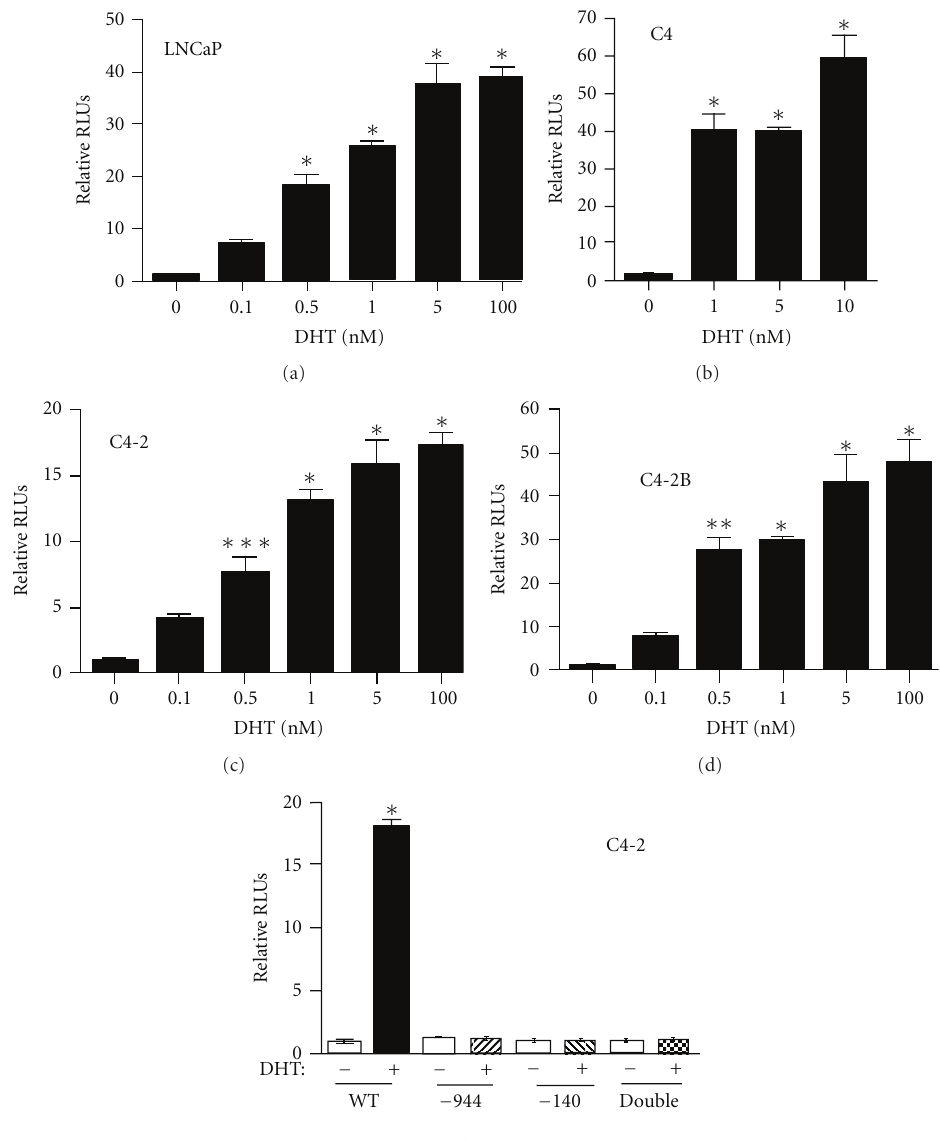
Figure 6: DHT induces the tcf8 promoter plasmid in a dose-dependent manner in LNCaP cell line derivatives . The LNCaP (a), C4 (b), C4-2 (c), and C4-2B (d) cell lines were transfected with the pBlueZEB974 promoter plasmid and then cultured with increasing DHT as indicated. The cells were harvested after 24 hrs and the β -galactosidase activity in the lysates was determined. (e) C4-2 cells were transfected with the wild type pBlueZEB974 plasmid or with the plasmids containing one or both AREs mutated. Data are plotted relative to the average with no DHT. ∗ P < 0 . 0001, ∗∗ P < 0 . 01, ∗∗∗ P < 0 . 05. line established from a lymph node metastasis [42]. The LNCaP C4-2 and C4-2B lines are two derivatives that have metastatic potential. They are androgen independent (Figure 6(c)), or C4-2B (Figure 6(d)) cell lines with in- for growth in castrated hosts but still have androgen- creasing amounts of DHT. In all cases, expression of the responsive AR. We hypothesized that ZEB1 expression tcf8 promoter was strongly induced by DHT in a dose- increases independently of androgen in these metastatic lines dependent manner, and the level of expression did not and contributes to androgen-independent PCa cell prolifer- correlate with metastatic potential. However, in contrast to ation, comparable to what occurs with ZEB1 expression in what was observed with the PC-3/AR cells (Figure 1), high advanced ovarian and endometrial cancers [40]. If true, this concentrations also induced expression. As was seen with inappropriate expression of ZEB1 might contribute to the androgen insensitivity observed in advanced PCa. the PC-3/AR line, both AREs are required for